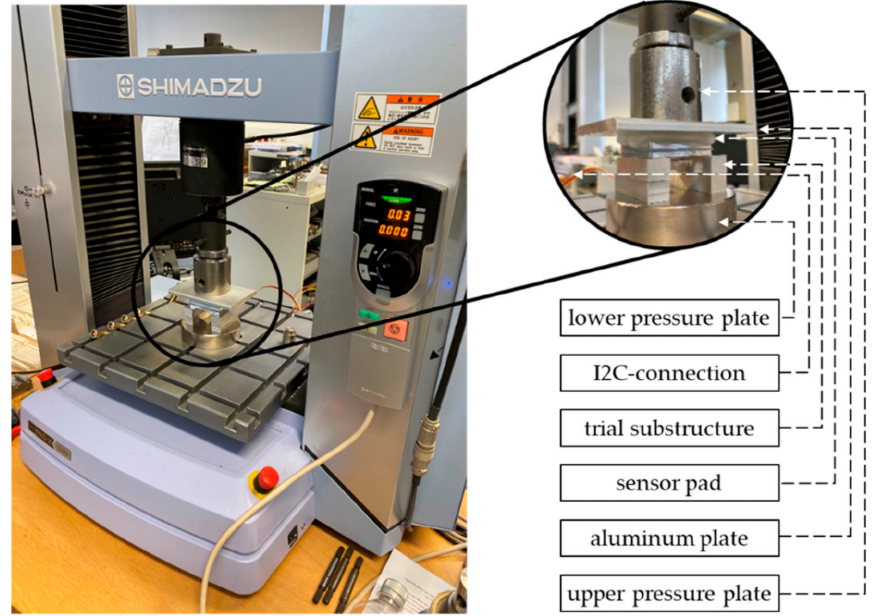
Figure 3. Clamp of the sensor pad in the material-testing